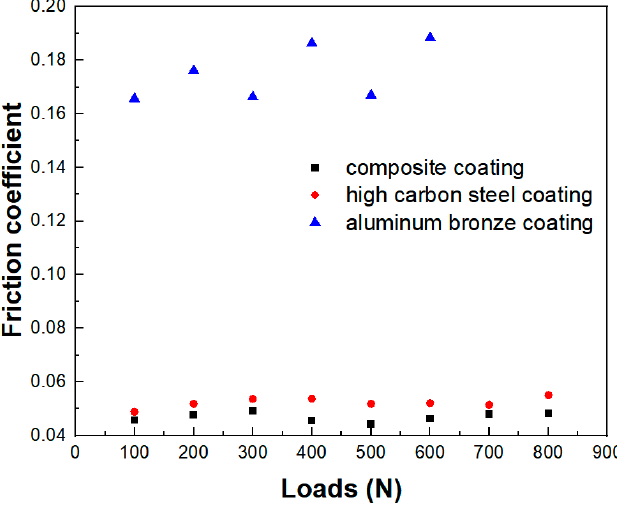
Figure 12. The samples after the friction and wear experiment: ( a ) sample with high-carbon steel coating; ( b ) sample with composite coating; ( c ) sample with aluminum bronze coating; ( d ) and paired sample in the experiment.